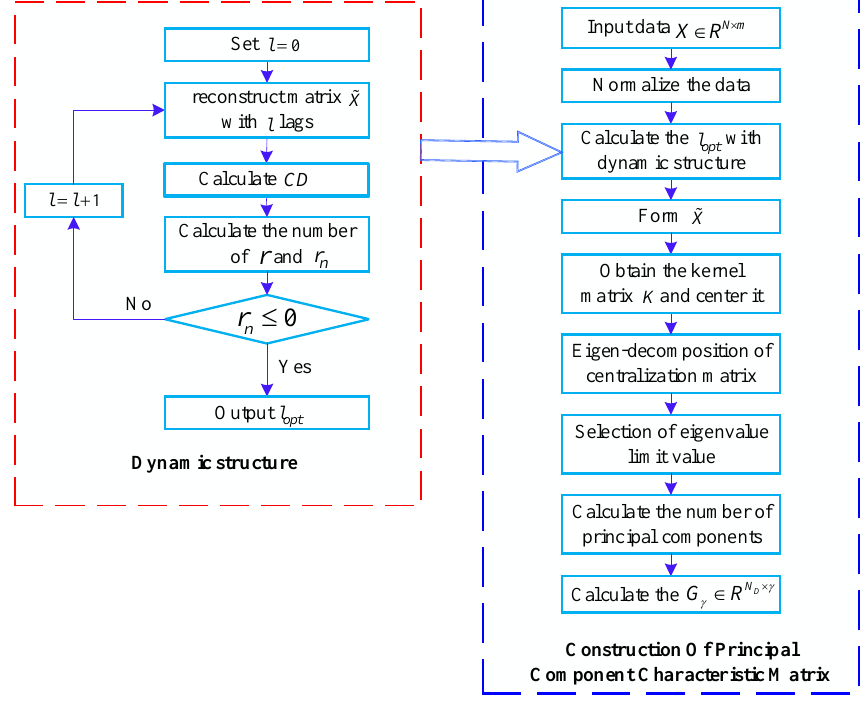
Figure 2. Schematic diagram of DKPCA.